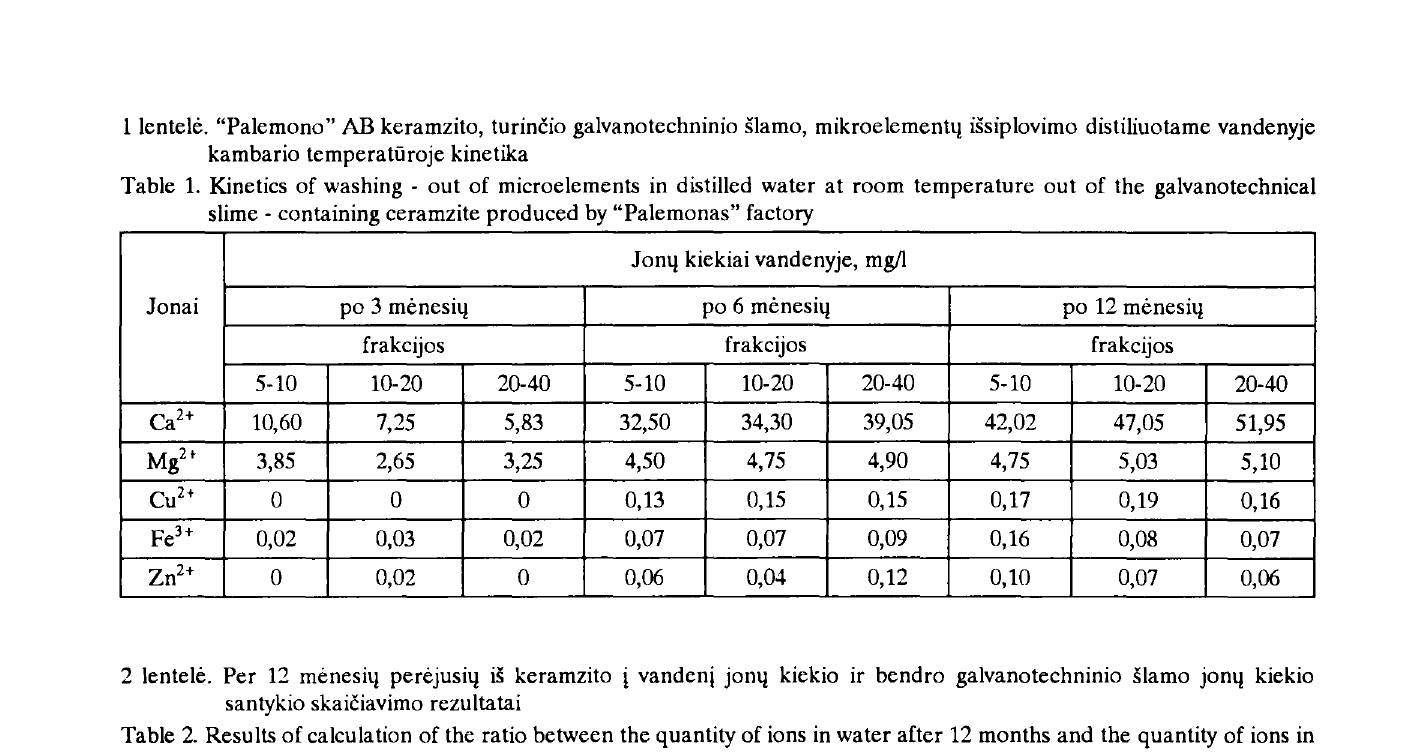
Table 2. Results of calculation of the ratio between the quantity of ions in water after 12 months and the quantity of ions in galvanical sludge Maksimalus Po 12 men. galvanotech- Jonas